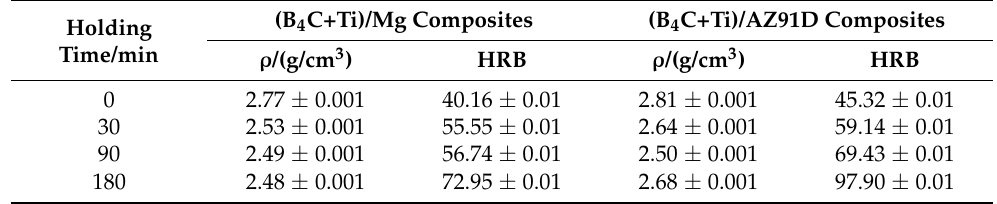
Table 1. Density and hardness of (B 4 C+Ti) hybrid-reinforced Mg and AZ91D composites.